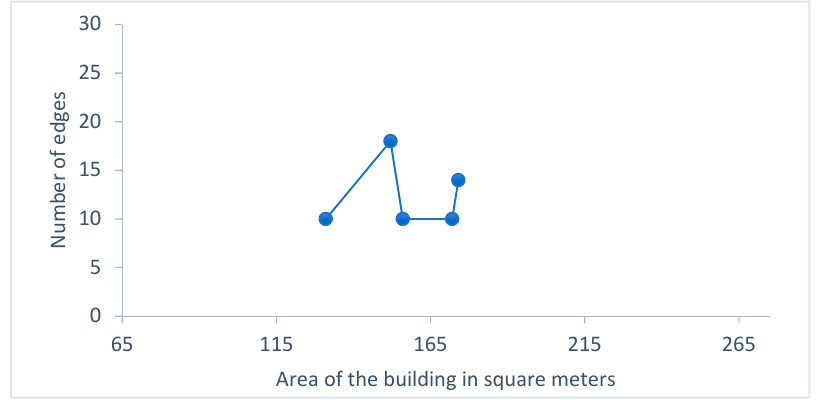
Figure 10. Efficiency of the method by Merrell et al. [19], observed based on the number of edges that are necessary to draw the shape of the building boundary. Values in this research range from 10 to 18.